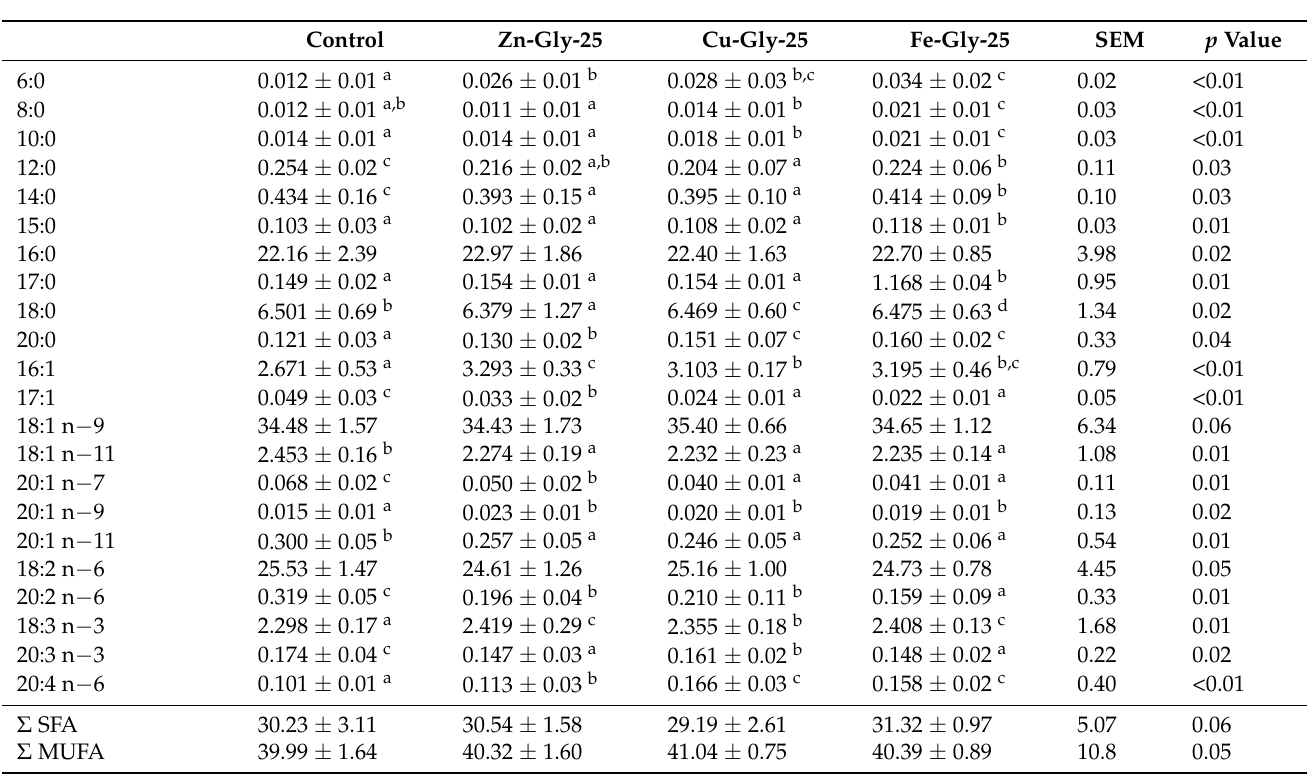
Table 6. Fatty acid profile (g/100 g of total fatty acids) and dietetic values of thigh meat samples—treatment II (25% of the mineral in the form of